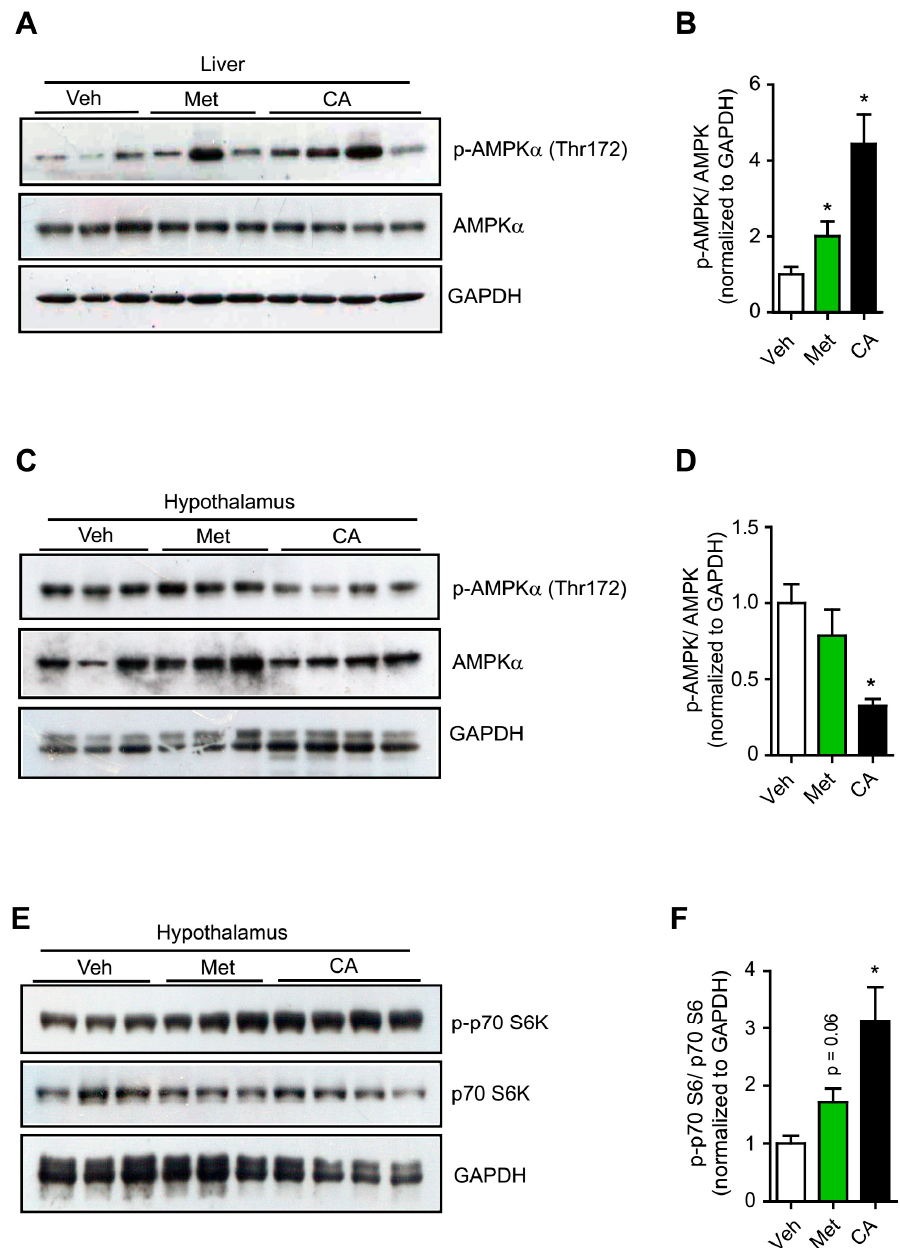
Figure 2. CA differential effects on AMPK activation in vivo. Immunoblots ( A ) and graph ( B ) showing effects of CA and metformin (met) treatments on AMPK activation in the mice livers. Immunoblots ( C ) and graph ( D ) showing effects of CA and metformin treatments on AMPK activation in the hypothalamic samples. Immunoblots ( E ) and graph ( F ) showing effects of CA and metformin treatments on p70S6K activation in the hypothalamic samples. The results are expressed as mean ± SEM. One-way ANOVA with Tukey’s post-hoc tests for comparison of multiple groups or Student’s t -test. * p < 0.05. Veh: vehicle.